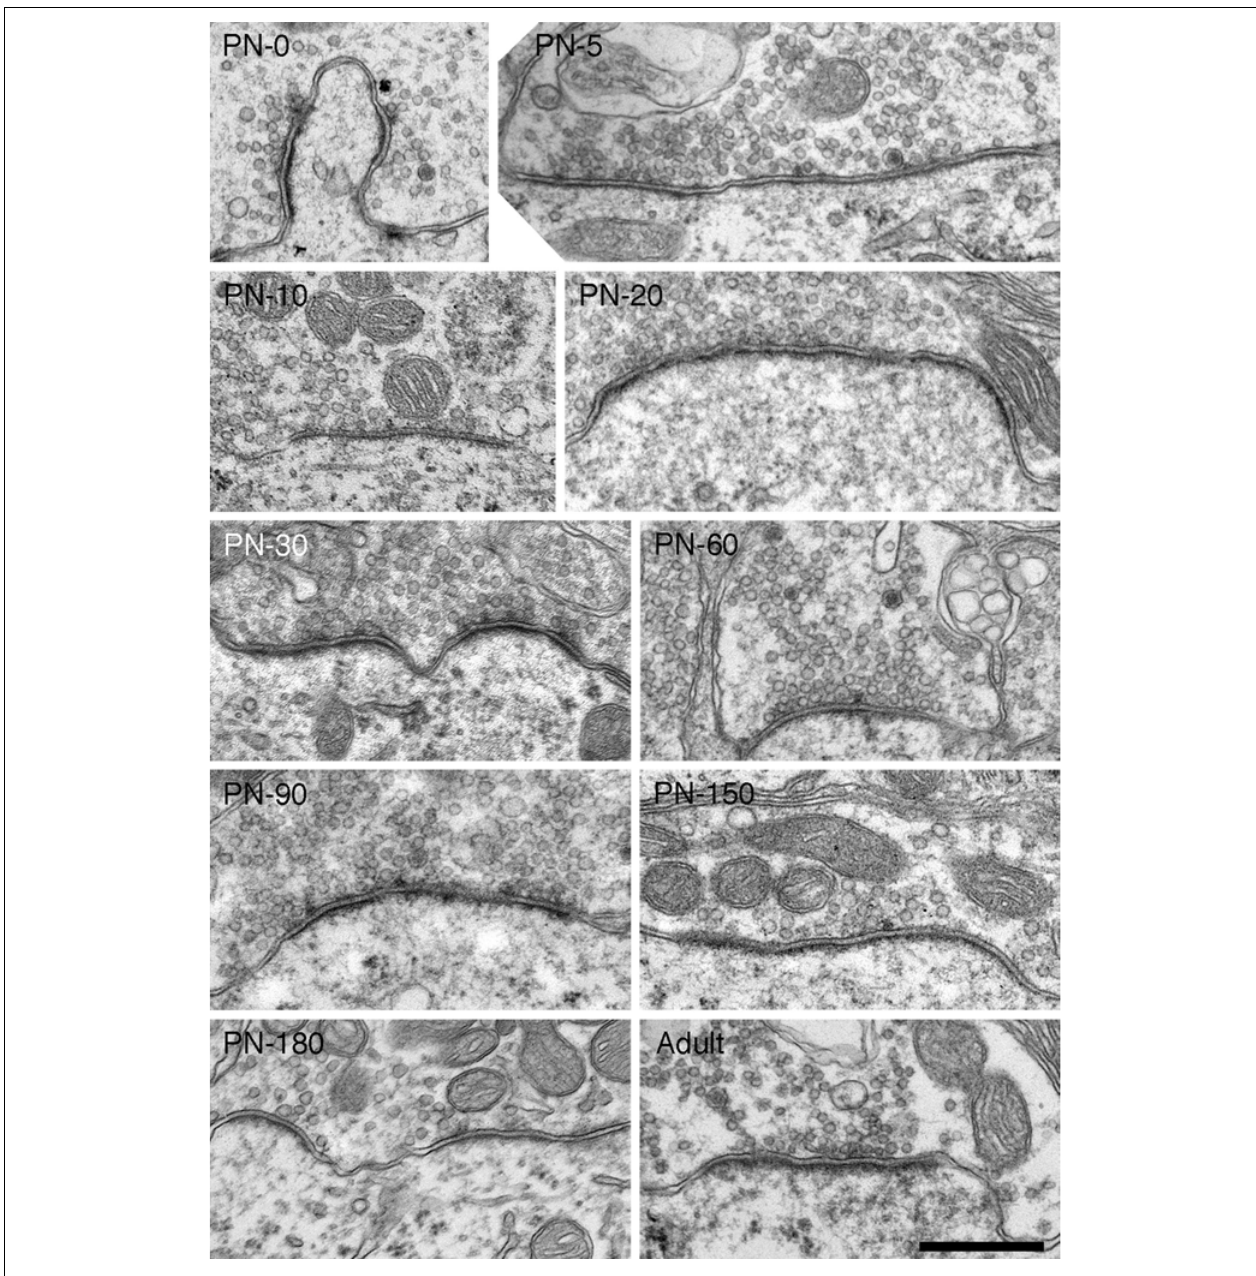
cats are nearly as large those in mature hearing cats. At all ages, synapses of deaf cats are substantially elongated and fl attened compared to those of age-matched hearing animals, including those of hearing littermates. As endbulbs mature, average PSD length grows as does the number of synaptic vesicles associated with synapses. Scale bar equals 0.5